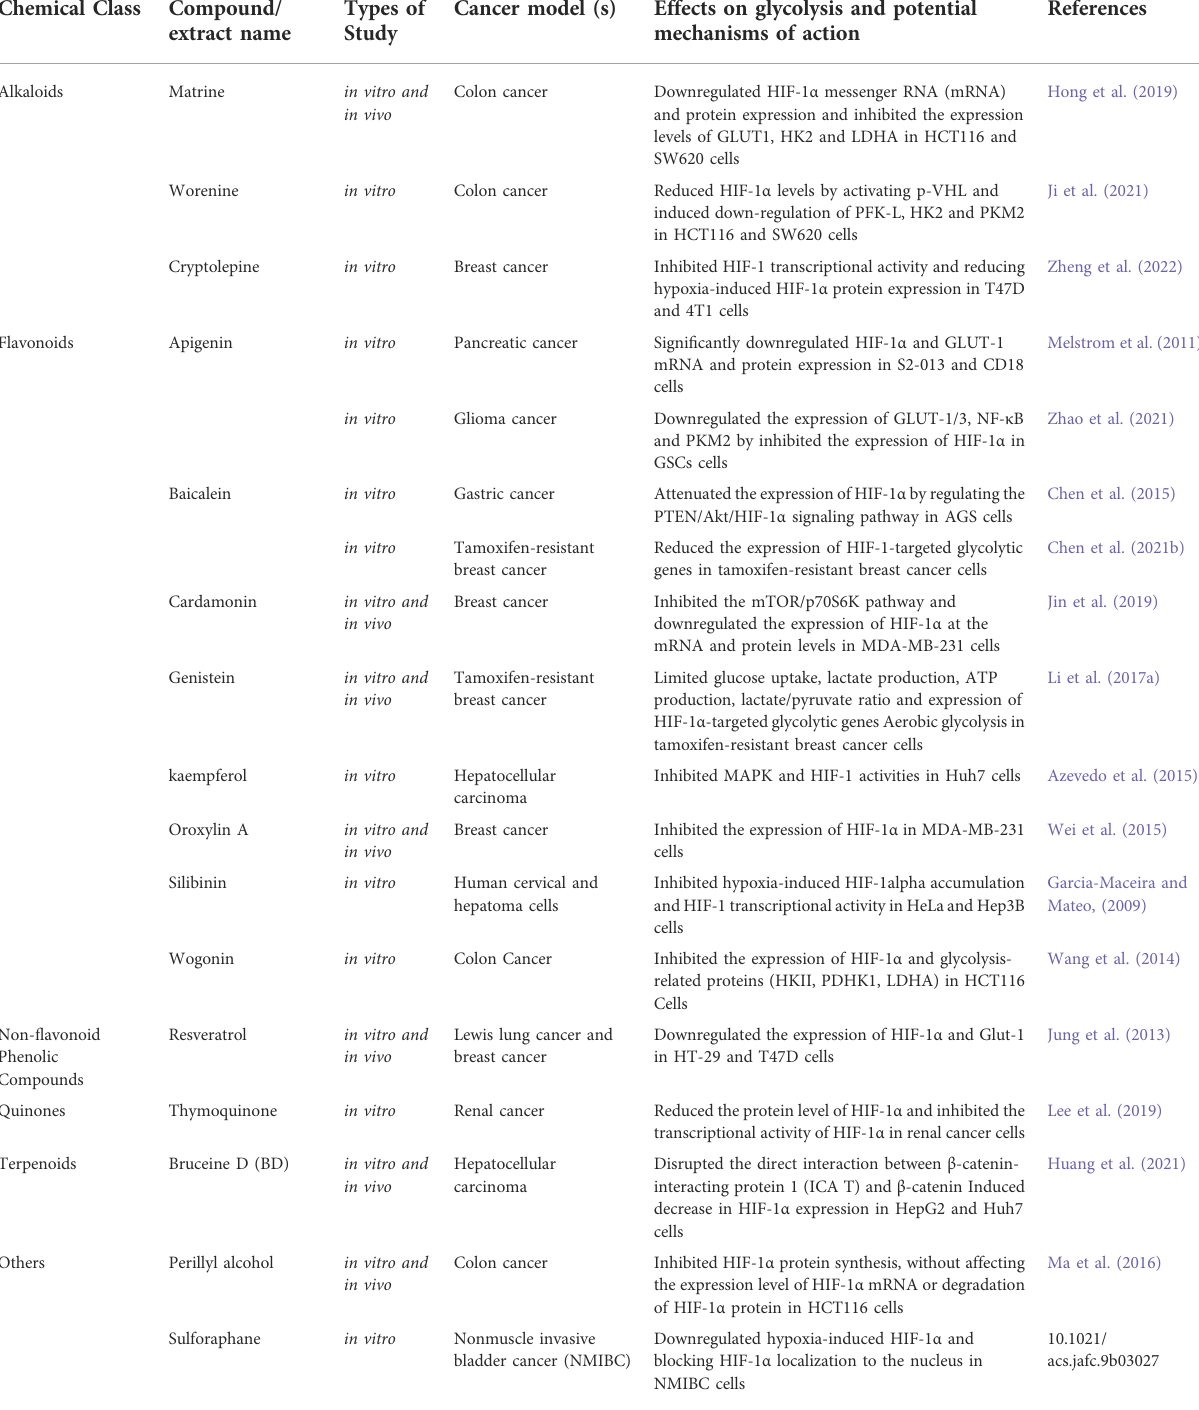
TABLE 6 Natural compounds target Hypoxia-inducible factor 1 α (Hif-1 α